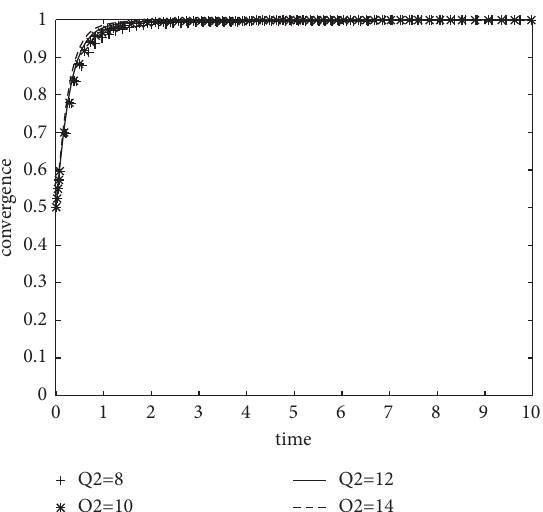
Figure 13: Changing the impact of Q